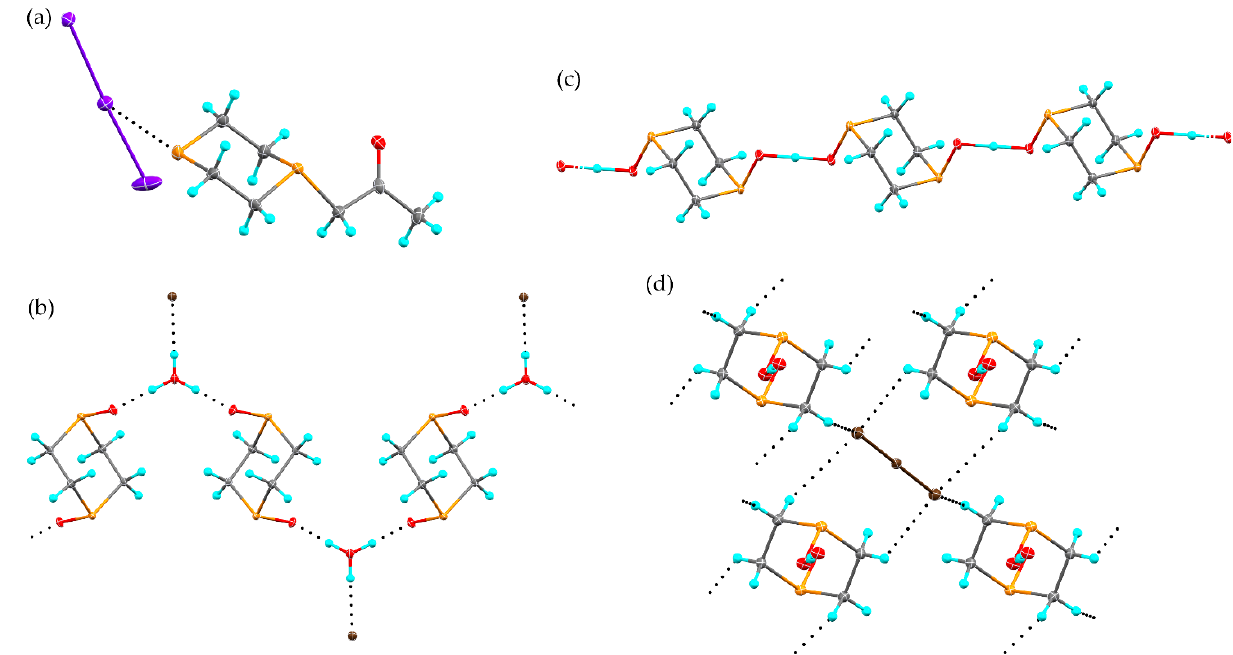
Figure 5. The solid-state structure of 7 ( a ), 8 ( b ), and 9 ( c , d ). Both the O ··· H ··· O hydrogen-bonded chains ( c ) and connection of neighboring chains by C-H ··· Br hydrogen bonding ( d ) are shown. Bromine atoms are brown. Oxygen atoms are red. Intermolecular interactions are shown as black dotted lines. Atomic displacement ellipsoids are shown at the 50% probability level.